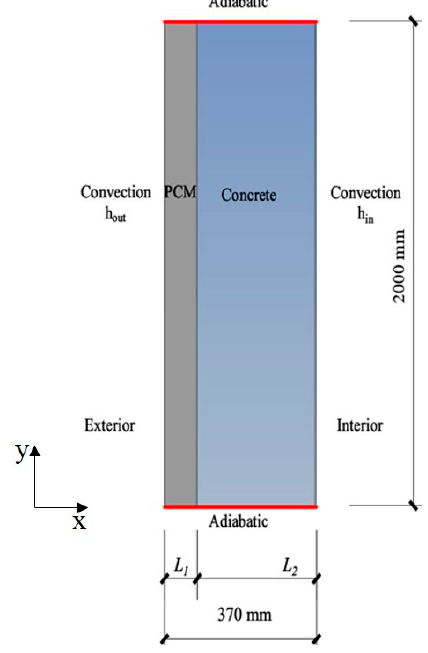
Figure 2. Physical model of grain bin wall (L1: 40 mm; L2: 330 mm).